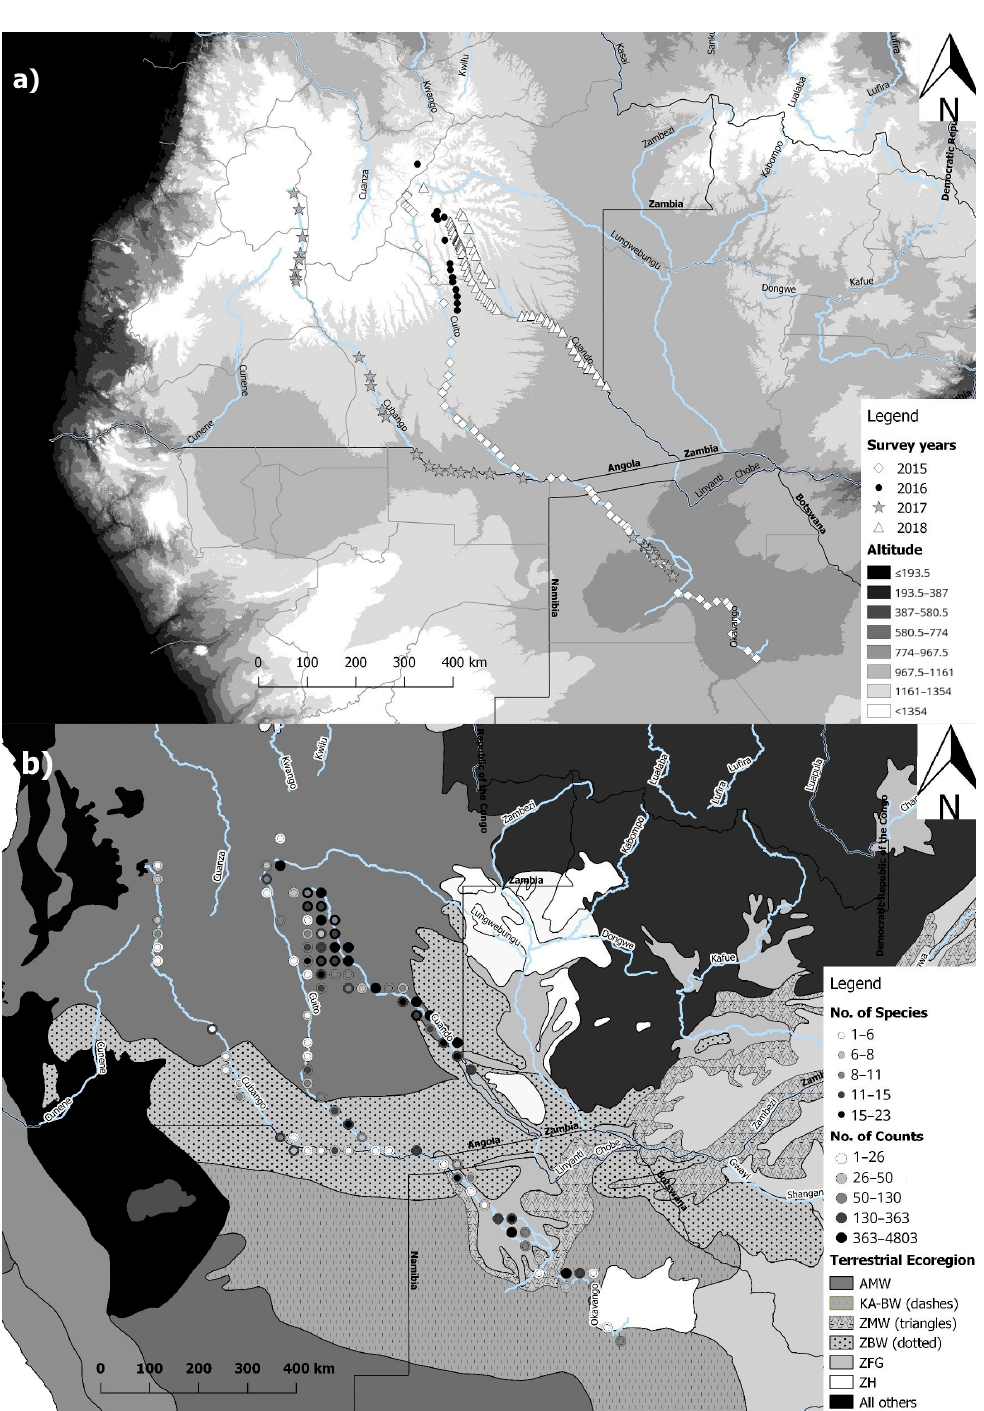
Figure 1. Map showing ( a ) the four different survey years and transect over elevation and ( b ) the differences in number of bats species and number of passes recorded with bat detectors in the different ecoregions in the Okavango Basin of Angola, Namibia and Botswana (AMW = Angolan Miombo woodland; KA-BW = Kalahari Acacia-Baikiaea woodlands; ZMW = Zambezian and Mopane woodlands; ZBW = Zambezian Baikiaea woodlands; ZFG = Zambezian flooded grasslands; ZH = Zambezian halophytics).